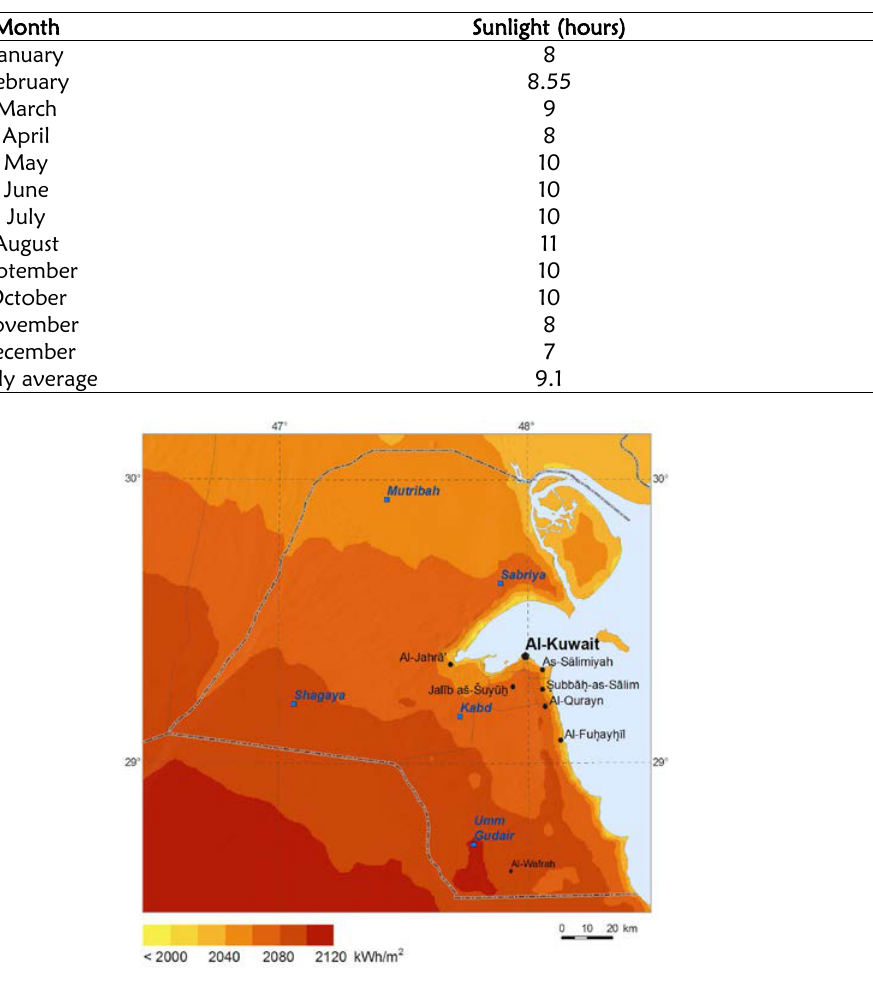
Table 1: Monthly sunshine hours for Shagaya, Kuwait